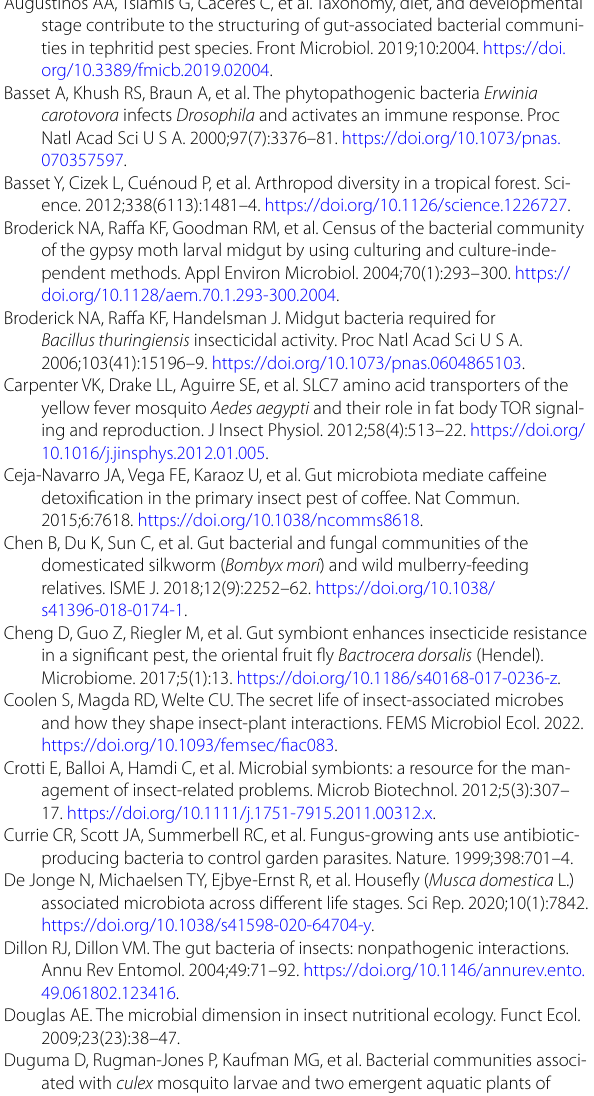
ent group. Table S3 . Relative abundance of bacteria communities at the genus level in different group (Top 15). Fig. S1 . Alpha diversity dilution